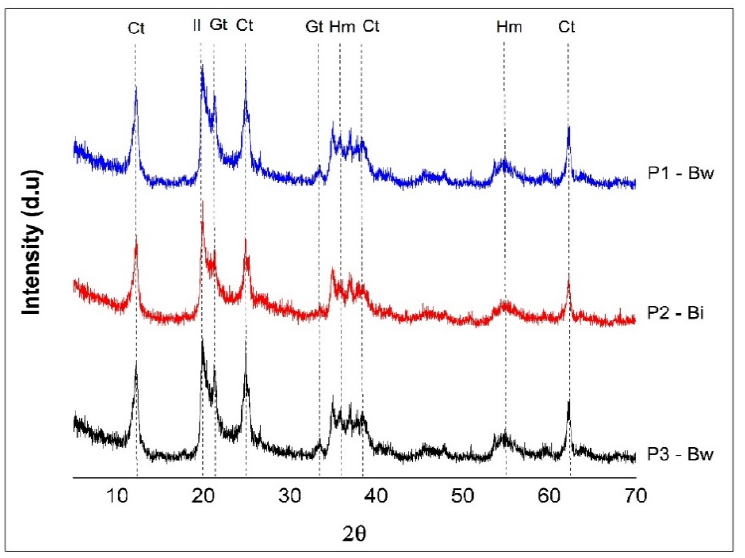
Figure 2. XRD in the natural clay of the diagnostic horizons of the most developed horizons. Ct: Kaolinite; Il: Illite; Gt: Goethite; Hm: Hematite; P1: Red-yellow Ferralsol—Bw; P2: Haplic Cambisol—Bi; P3: Yellow Ferralsol—Bw.